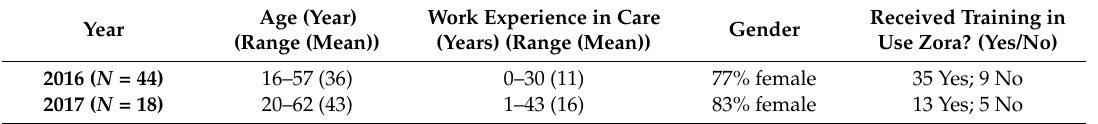
Table 1. An overview of the professionals’ characteristics in the two research